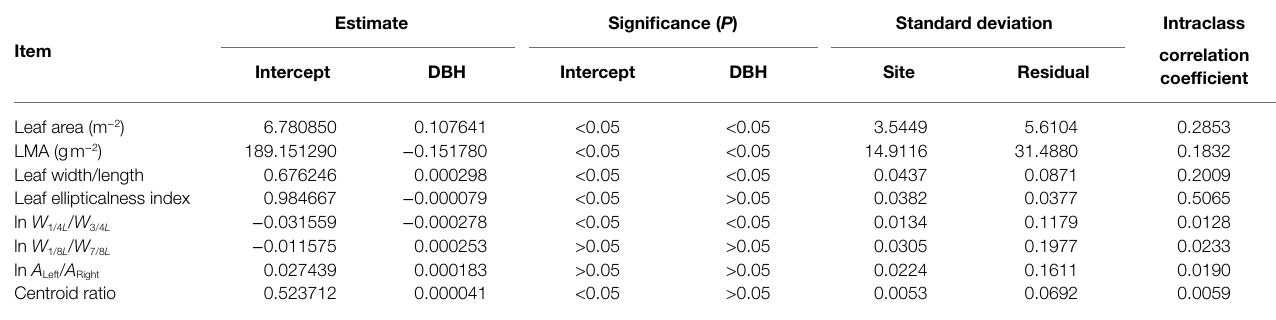
TABLE 2 | Fitted results of the linear mixed model to eight leaf size and shape indices.